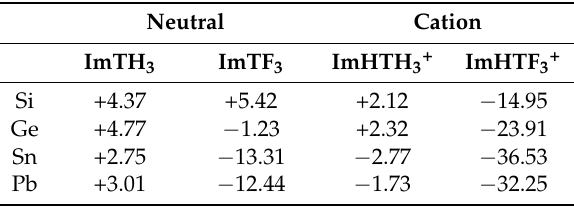
Table 3. ∆ G(298 K) (kcal/mol) for interactions between Cl − and ImTR 3 and ImHTR 3+